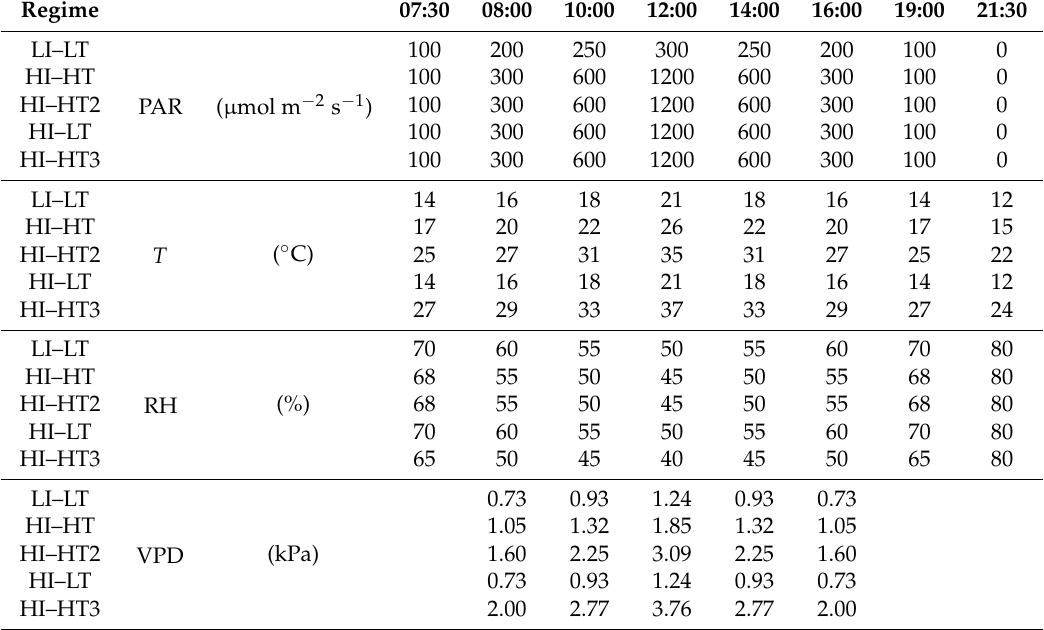
Table 1. Daily courses of photosynthetically active radiation intensity (PAR), air temperature ( T ), relative air humidity (RH), and vapor-pressure deficit (VPD) in growth chambers during the individual combined regimes of PAR intensity and temperature.